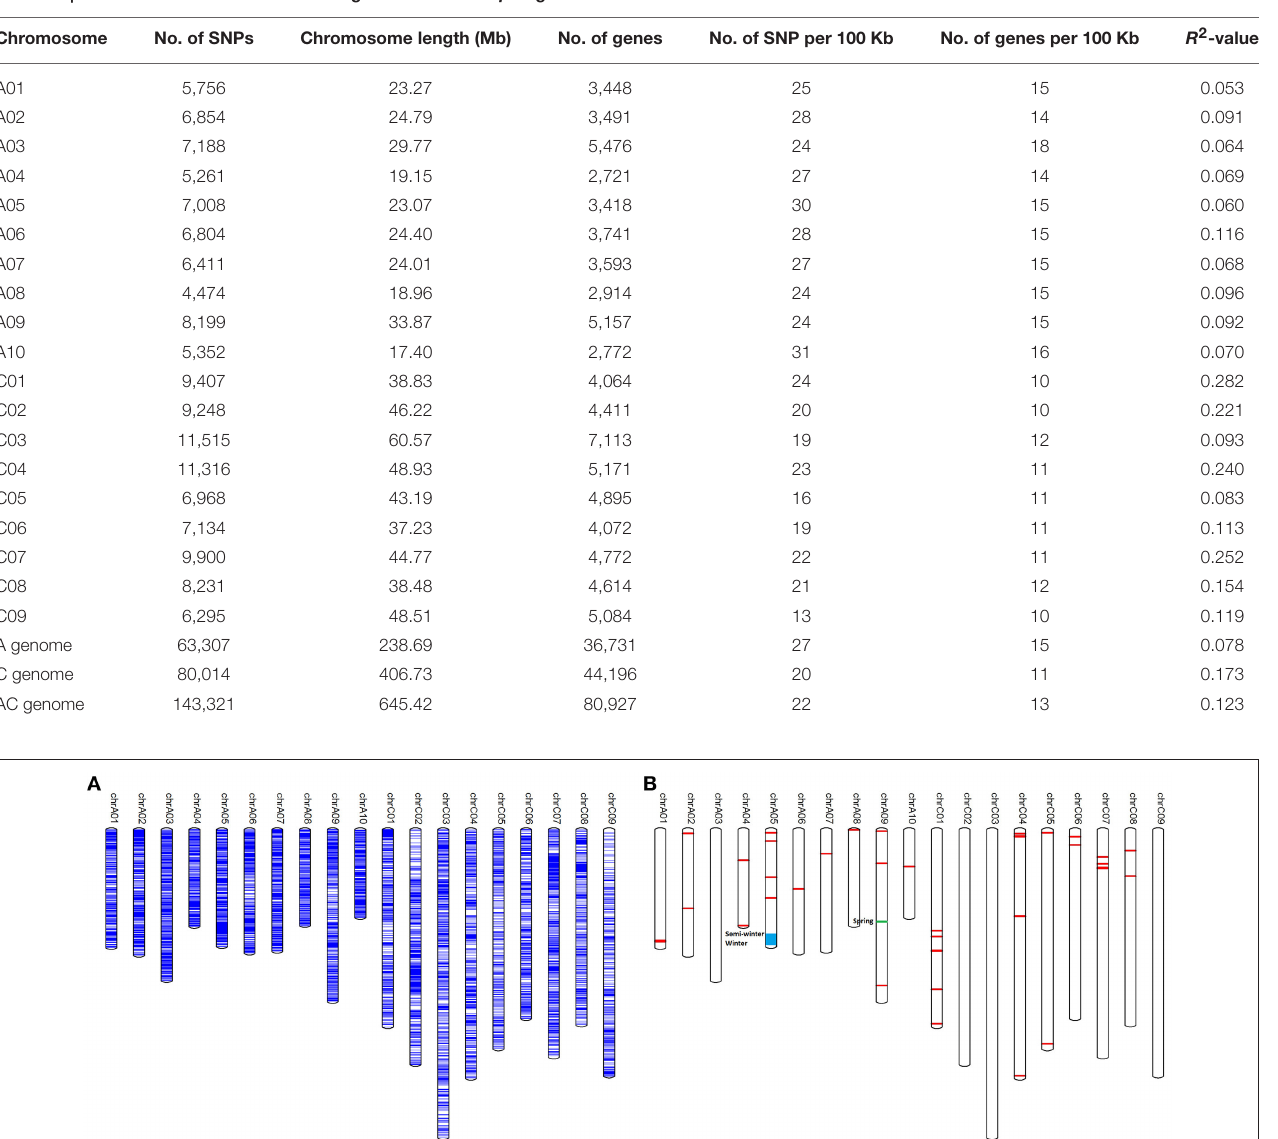
Frontiers in Plant Science |